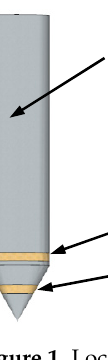
Figure 1. Locations of u 1 and u 2 pore pressure measurements.